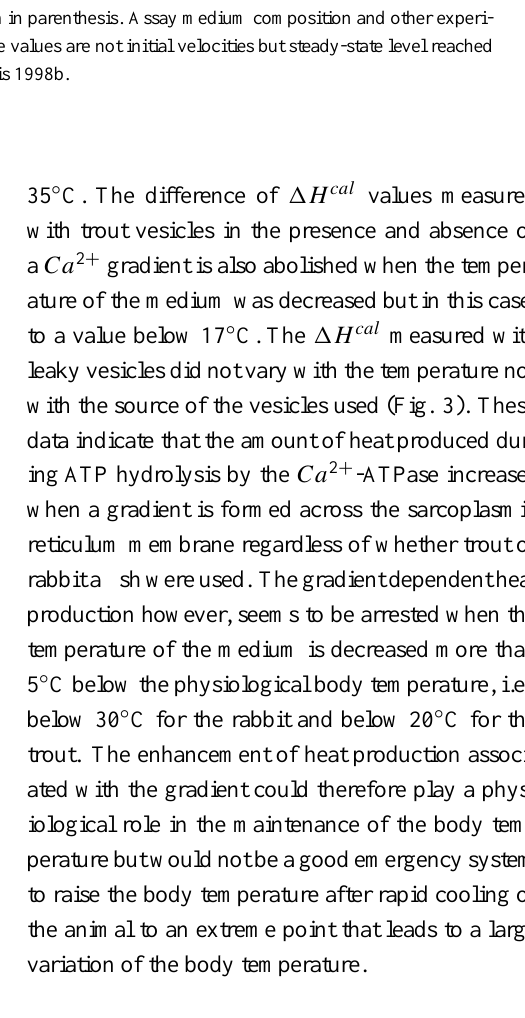
Values are means ± SE of the number of experiments shown in parenthesis. Assay medium composition and other experi- mental conditions were as described in Table I. Ca 2 + uptake values are not initial velocities but steady-state level reached